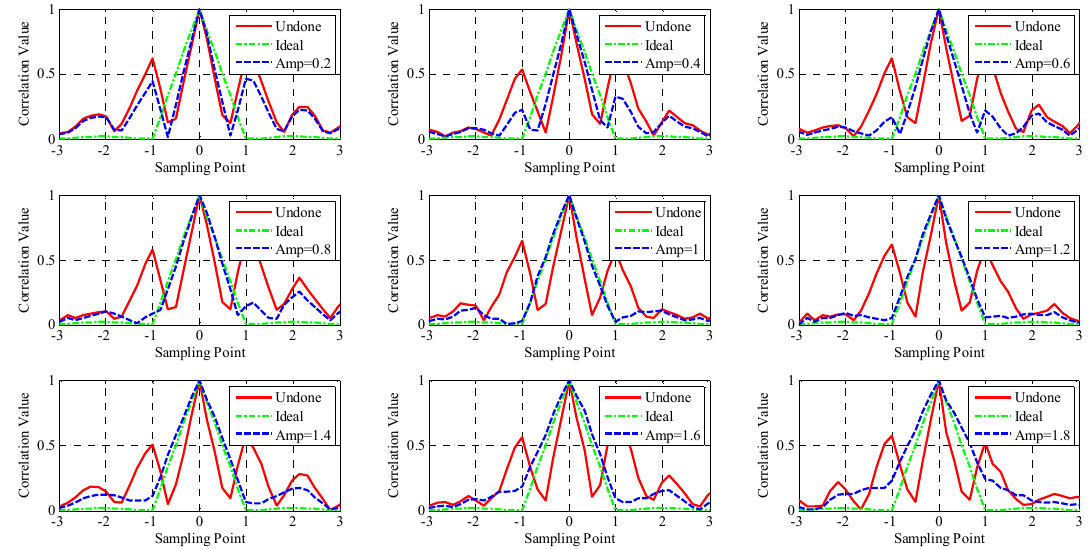
Figure 17. Sidelobes suppression results under different amplitude estimation accuracy.